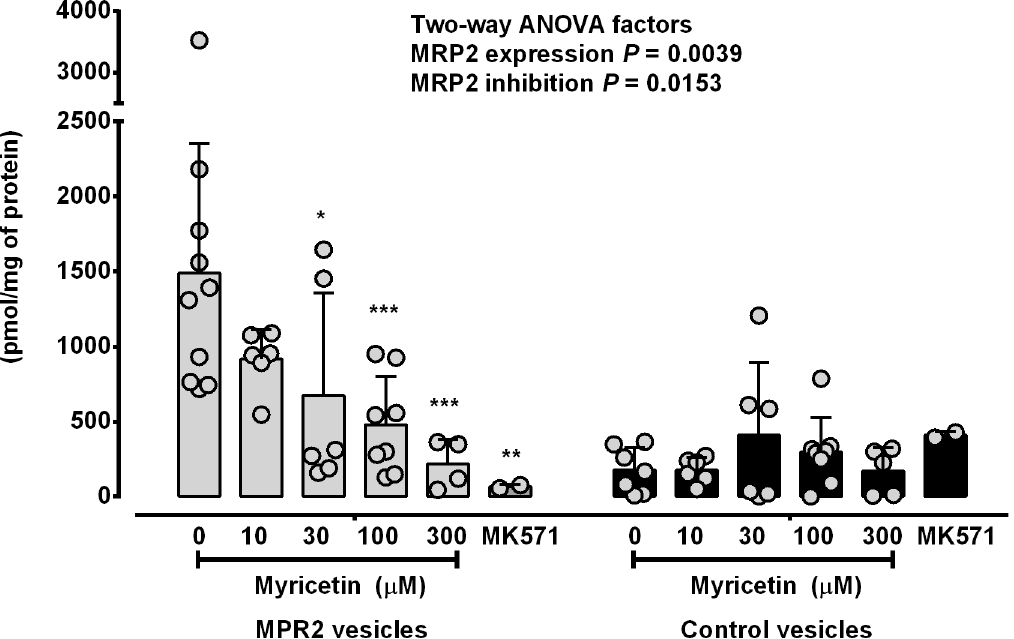
Fig 5. Effects of MRP2 inhibitors on membrane vesicle accumulation of oxaliplatin-derived platinum. MRP2-expressing and control membrane vesicles were incubated with oxaliplatin (100 μ M), ATP (4 mM) and MRP2 inhibitors for 10 minutes before measurement of platinum accumulation by ICPMS. The P values shown as numbers are from two-way ANOVA and those shown as * ( P < 0.05), ** ( P < 0.01) and *** ( P < 0.001) are from Tukey ’ s multiple comparison post-tests following two-way ANOVA for comparisons to MRP2-expressing membrane vesicles incubated with oxaliplatin and ATP but without MRP2 inhibitors. Bars represent means and standard deviations of individual values (open symbols) pooled from at least two independent experiments. Light grey bars, MRP2-expressing membrane vesicles. Black bars, control membrane vesicles.